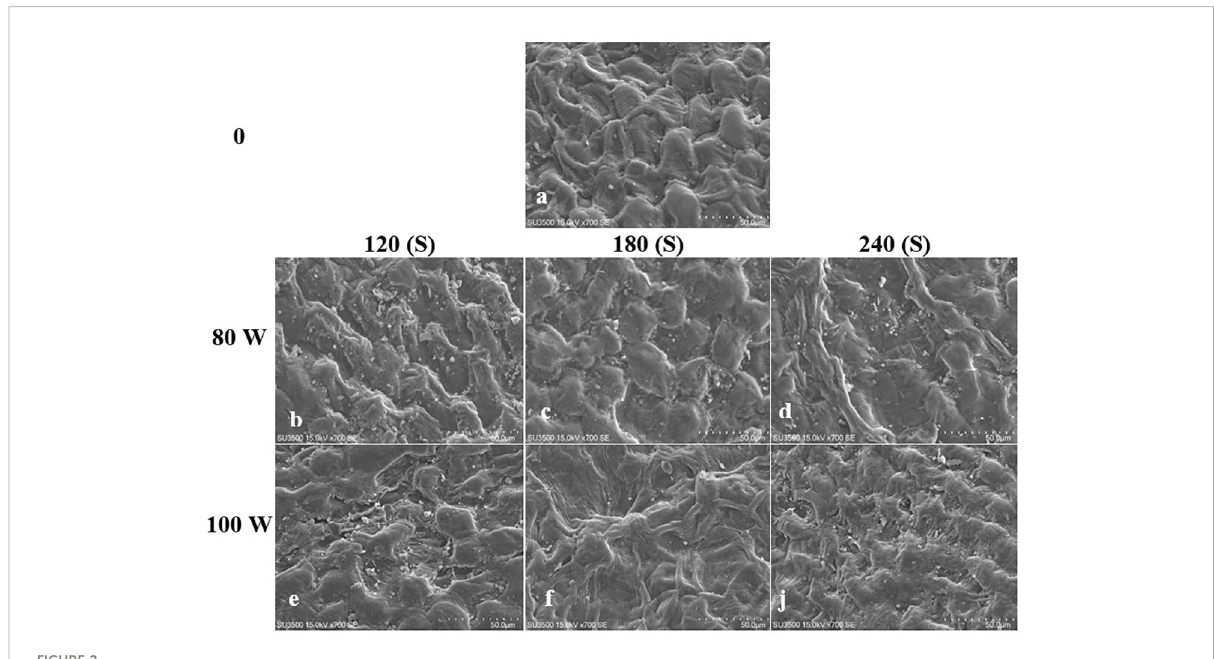
FIGURE 2 Scanning Electron Microscope (SEM) images of the normal seed (NS) surface of S. leriifolia under cold plasma. (A) NS, (B) NS in 80 W 120s, (C) NS in 100 W 120s, (D) NS in 80 W 180s, (E) NS 100 W 180s, (F) NS in 80 W 240s, (J) NS 100 W